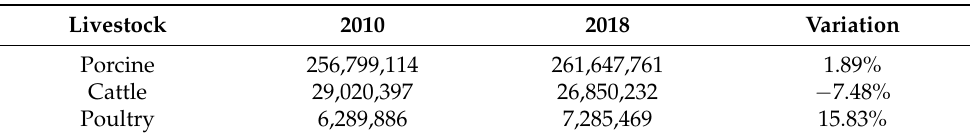
Table 4. Estimated number of poultry ( × 1000), porcine and cattle heads in the EU(28) in 2010 and 2018. Livestock represented as number of heads [102]. Variation represented as %.